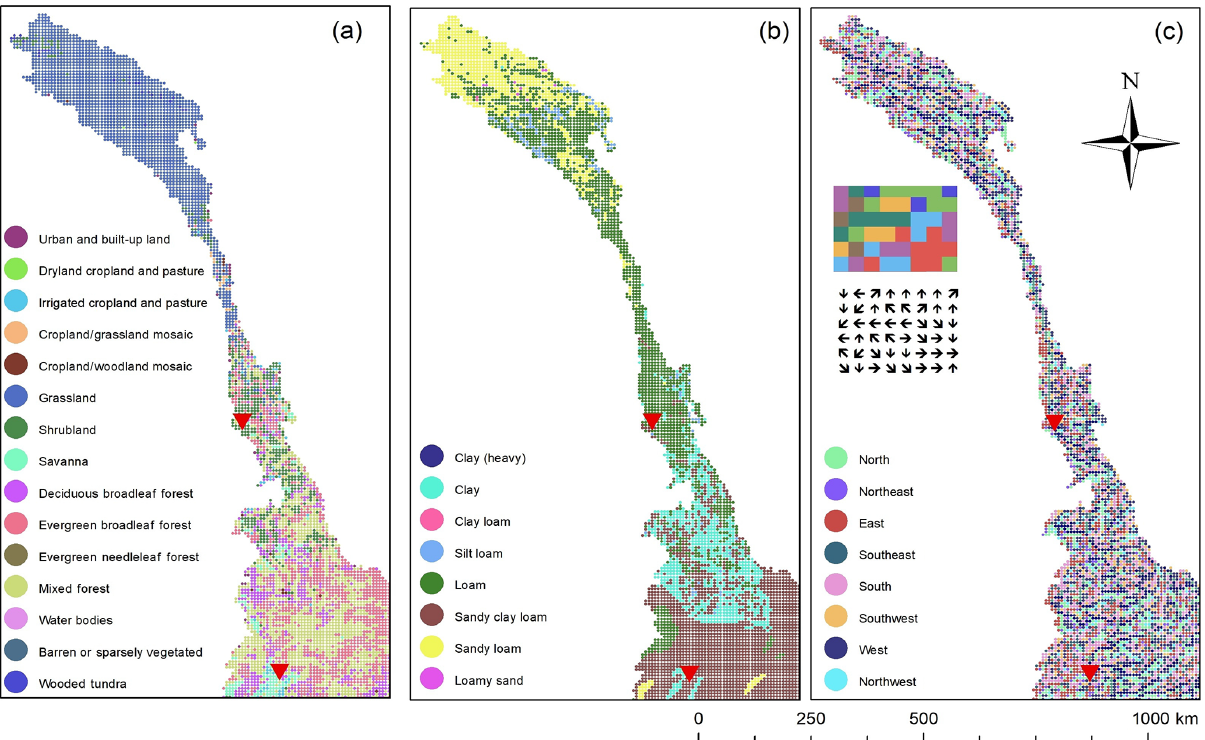
Figure 4. Land use map derived from the Global Land Cover Characterization dataset (a) ; soil map (for the top layer) retrieved from the Harmonized World Soil Database (b) ; flow direction map (c) . The red triangles denote the position of the Chiang Saen and Jiuzhou gauging